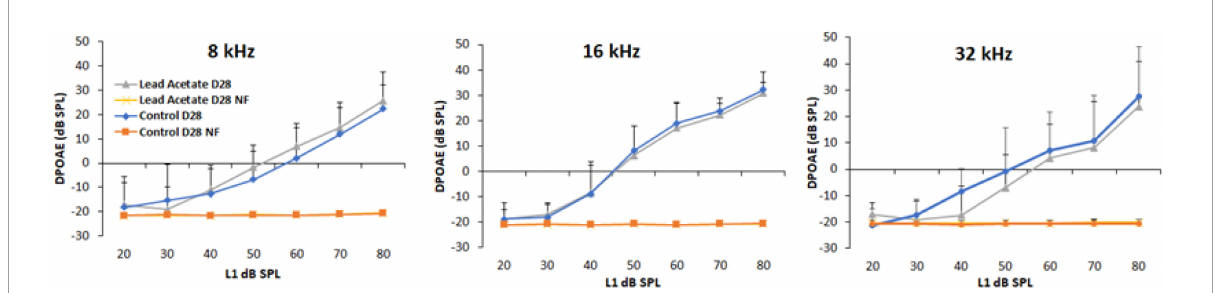
FIGURE2 Effect of lead exposure on outer hair cell activity. Distortion product otoacoustic emissions (DPOAEs) were recorded in control and lead-exposed mice using 8, 16, and 32 kHz f2 stimuli. The traces labeled NF represent the noise floor of the DPOAE recordings. The distortion product amplitudes of mice with 28-day lead exposure were largely similar to that of unexposed controls. The results are expressed as mean ± standard deviation, n = 4–5.